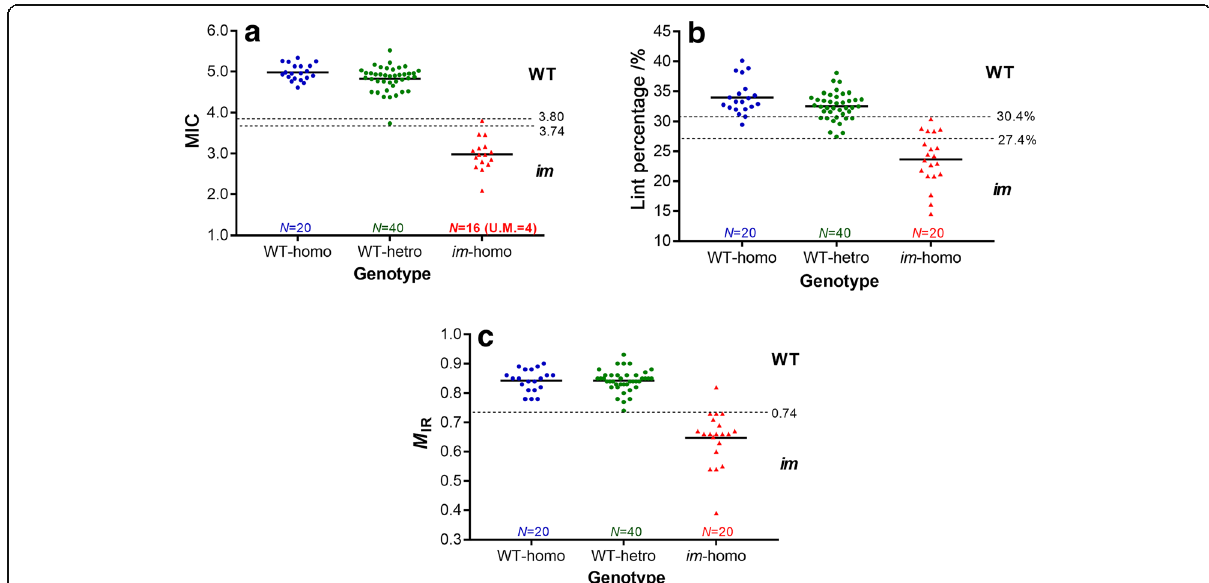
Fig. 6 Scatter dot plot of the 2nd set cotton materials comparing phenotypes with genotypes. Comparisons of the genotypes with the observed MIC phenotypes ( a ), the observed lint percentage phenotype ( b ), and the observed IR maturity M IR values ( c ). Genotypes of the 80 F 2 progeny plants were classified into WT-homo (20 plants), WT-hetro (40 plants), and im -homo (20 plants) by genetic markers, and presented along the horizontal axis. Phenotypes were measured by MIC, lint percentage or M IR values, and compared with their genotypes. Threshold values were presented as a dashed line for classifying WT phenotype from im phenotype. N, numbers; U.M.